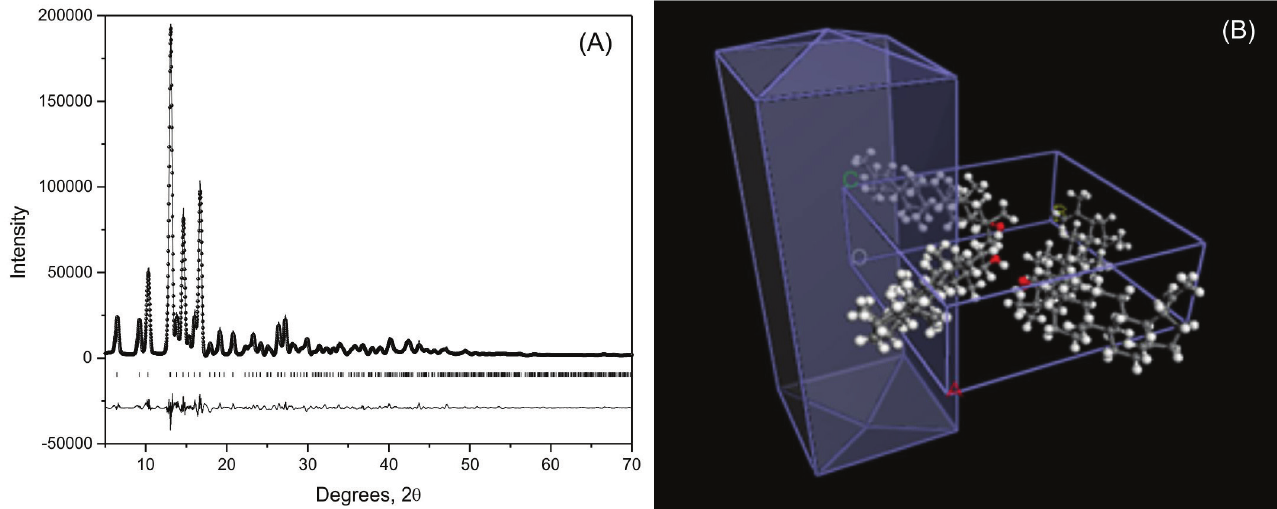
FIGURE 2 - Powder X-ray diffraction (XRD) data: (A) lupeol difratogram; (B) lupeol chemical structure, found in solid with a needle